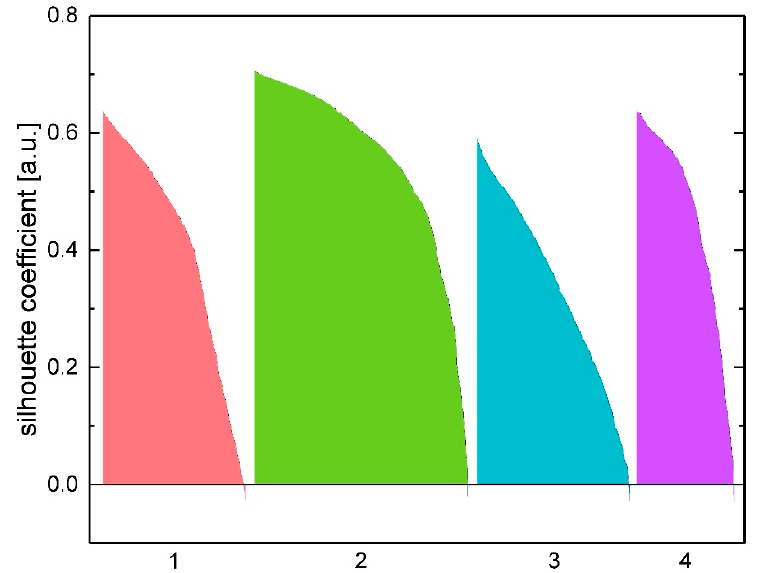
Figure 6. Silhouette width plot associated with the example experiment shown in Figure 5 (neuronal cells on TiN nanocolumnar surfaces after 3 days). The four clusters are color-coded. Positive values indicate a high-quality cell sorting result.